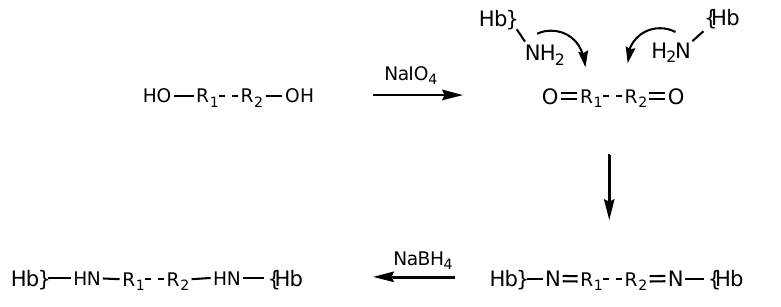
O . Conditions: 200 µM protein, 400 µM 2 2